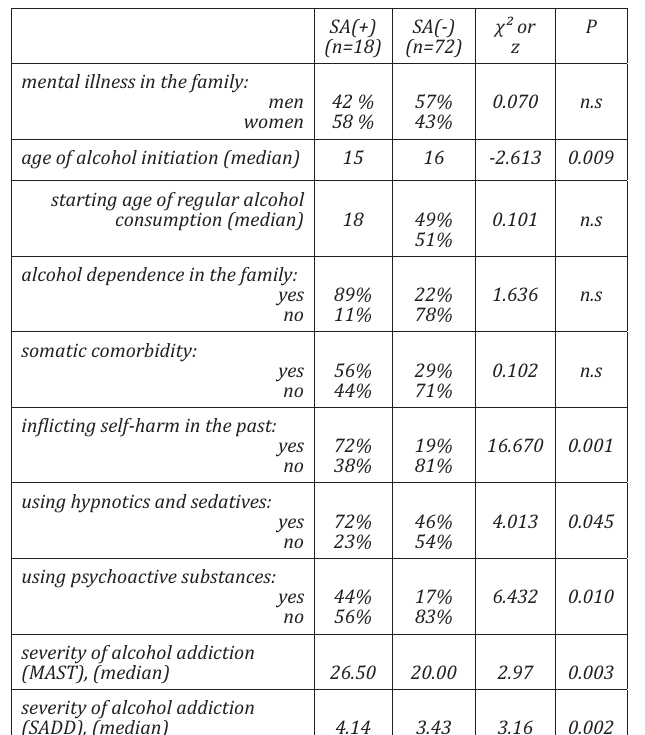
+ subjects were also characterized by significantly greater The data included in Table.2 shows that alcohol addicts alcohol dependence measured in the MAST (p = 0.003) and who attempted suicide in the past more often than those SADD (p = 0.002) scores and more frequent comorbidity of in the SA- group grew up in families in which at least one chronic somatic diseases (p = 0.035). A significantly higher member was addicted to alcohol (p = 0.050) or suffered from percentage of respondents with a history of suicide attempts a mental illness (p = 0.020). The alcohol drinking initiation had inflicted self-injuries in the past (p = 0.001), had used age (p = 0.019) and the starting age of regular alcohol other psychoactive substances (p = 0.010), hypnotics and consumption (p = 0.003) were statistically significantly Table 2. Comparison of selected clinical variables in alcohol addicts with sedatives (p = 0.045) (Tab.2). lower in subjects with a history of suicide attempts. The SA and without suicide attempts in the medical